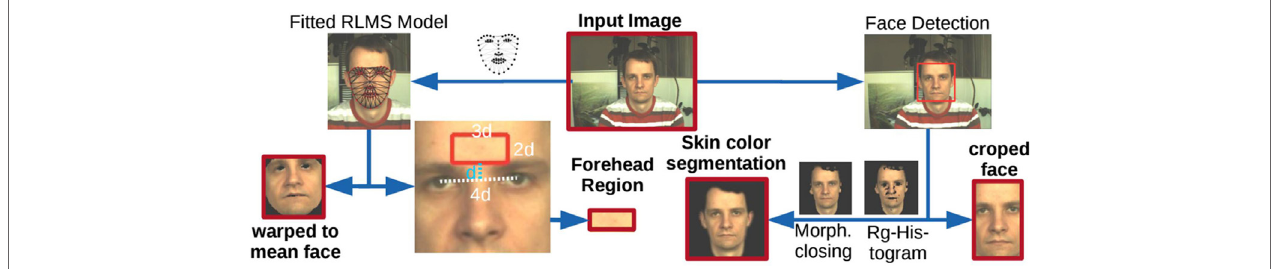
FigURe 4 | Overview of region of interest selection (Stricker et al.,